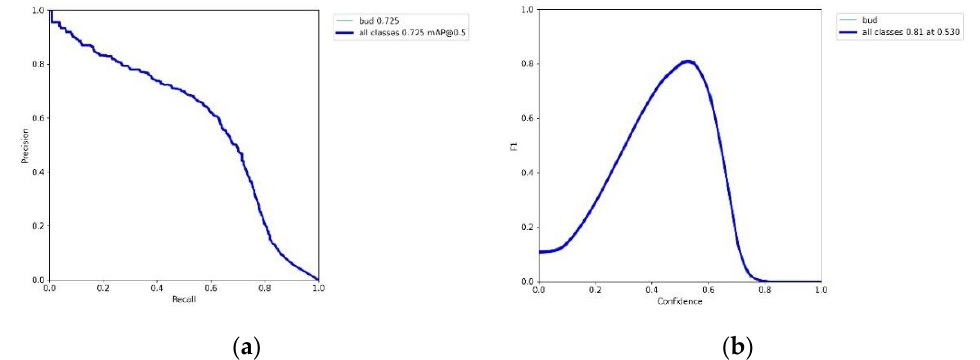
Figure A16. The changes of recall of Improved YOLOV5.